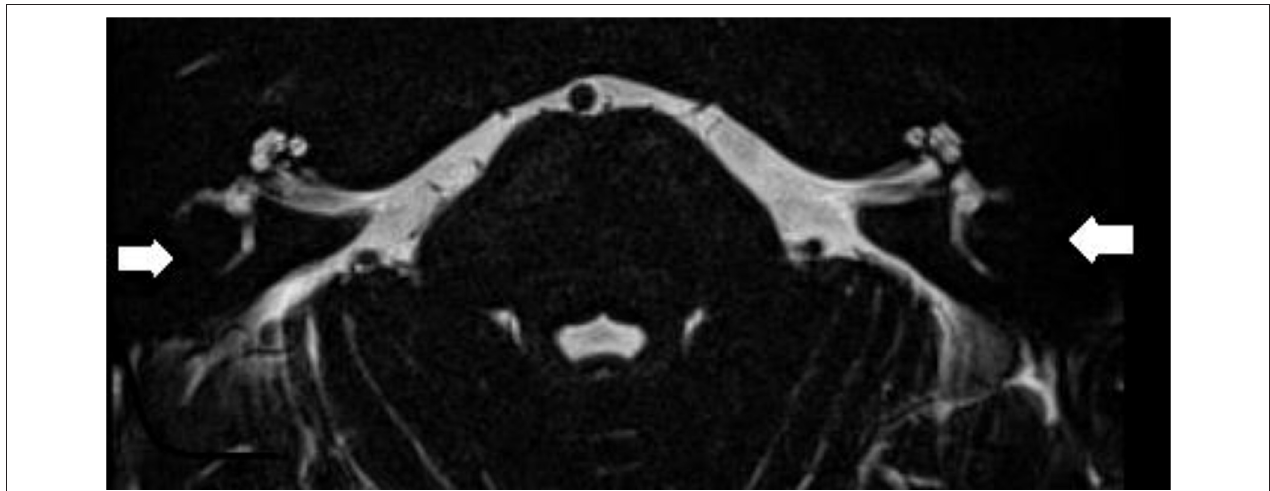
FIGURE 2 | Axial T2-weighted turbo spin echo MRI of the left and right labyrinth demonstrating signal loss in the lateral semicircular canal (arrow) corresponding to the axial CT slice in Figure 1